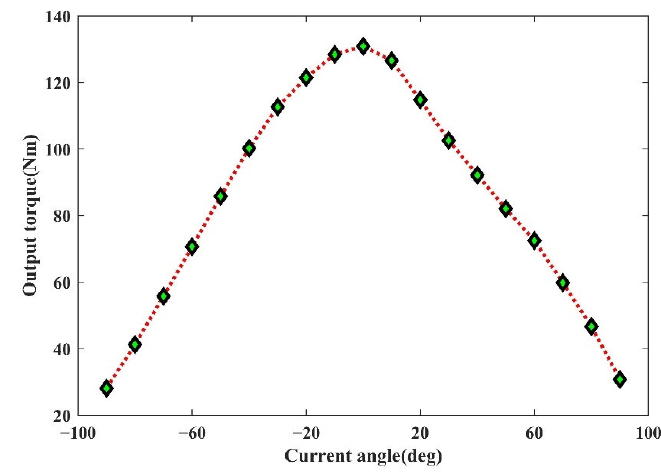
Figure 18. Influence of current angle on torque.